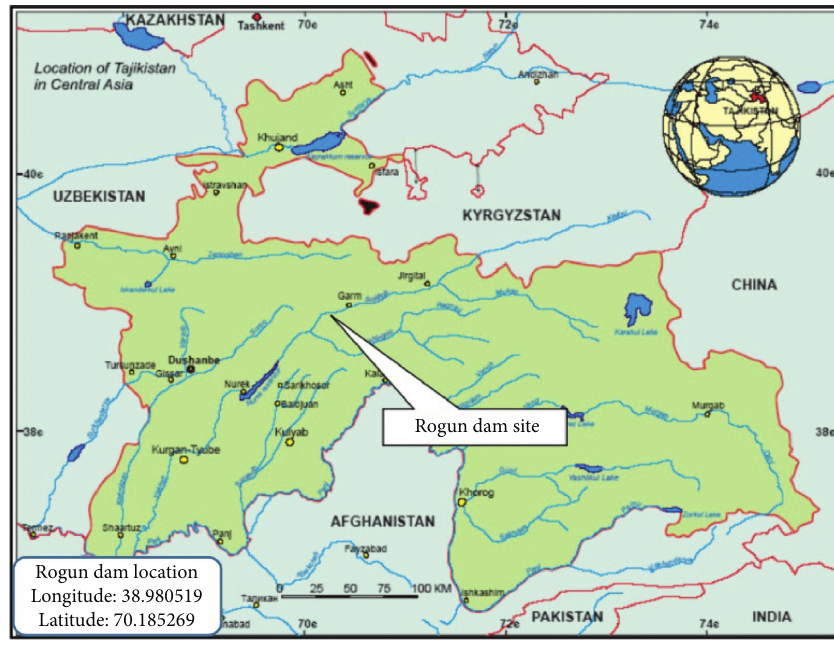
Figure 4: The location of Rogun HPP [56]. Table 2: Main parameters of the phased development scheme of Rogun HPP.